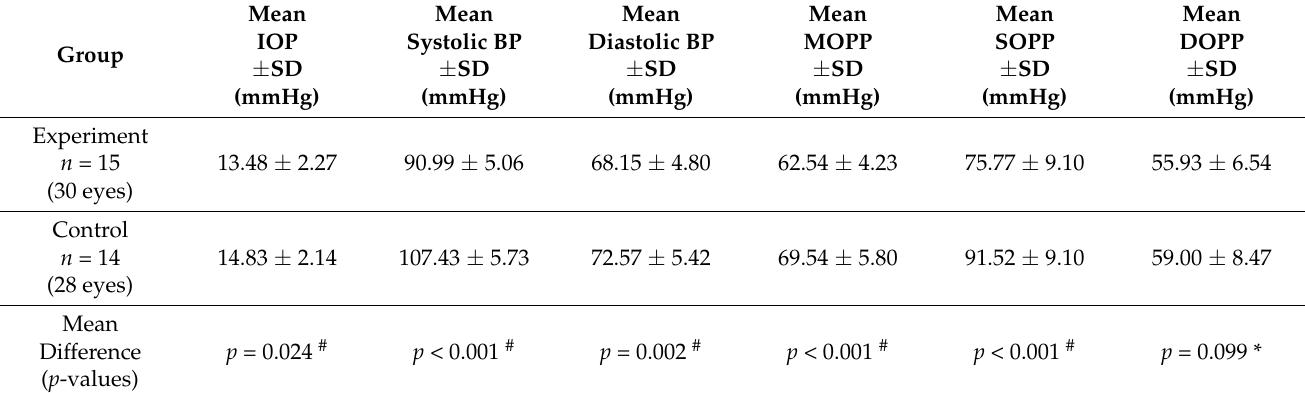
Table 1. The mean IOP, BP, and OPP measurements for both PSH (experimental) and normotensive (control) groups.